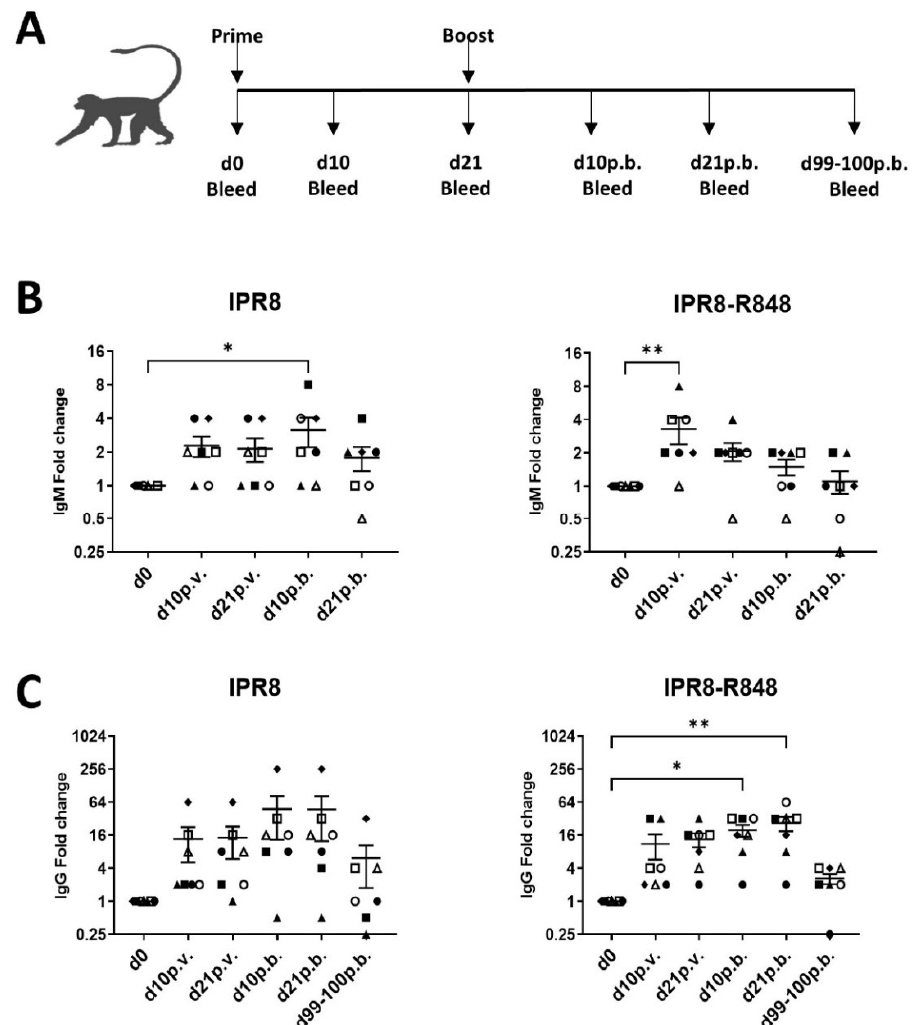
Figure 1. R848 adjuvantation promotes increased levels of antibody after primary vaccination in elderly AGM. ( A ) Elderly AGM were vaccinated with 45 µ g of IPR8 ( n = 7) or R848-adjuvanted IPR8 ( n = 7) by intramuscular injection. On d21 p.v., animals were boosted with the same vaccine they received as a prime. Blood was drawn on the day of vaccination (d0), d10 p.v., d21 p.v., d10 p.b., d21 p.b., and d99-100 p.b. The levels of circulating PR8-specific IgM ( B ) and IgG ( C ) were quantified from the plasma by ELISA (PR8 coated on well at 1 µ g per well). Threshold titer (TT) is defined as the highest dilution at which the sample’s optical density was at least 3 times that of the assay background. Fold change was determined by dividing the threshold titer at each time point by the d0 TT. Each animal is designated by a distinct symbol; these symbols are consistent across time points to allow for longitudinal visualization of each individual response. Antibody levels (fold changes) were compared within (d0 vs. d10 p.v., d21 p.v., d10 p.b., or d21 p.b.) groups using longitudinal mixed models. In these models, the individual animals were considered as random effects, while time, group, and time-by-group interactions were considered as fixed effects. In order to account for multiple comparisons (with d0 values), Tukey’s method was used to identify significant differences. The mixed-effects models were performed using Proc Mixed in SAS v9.4. * p = < 0.05, ** p = <